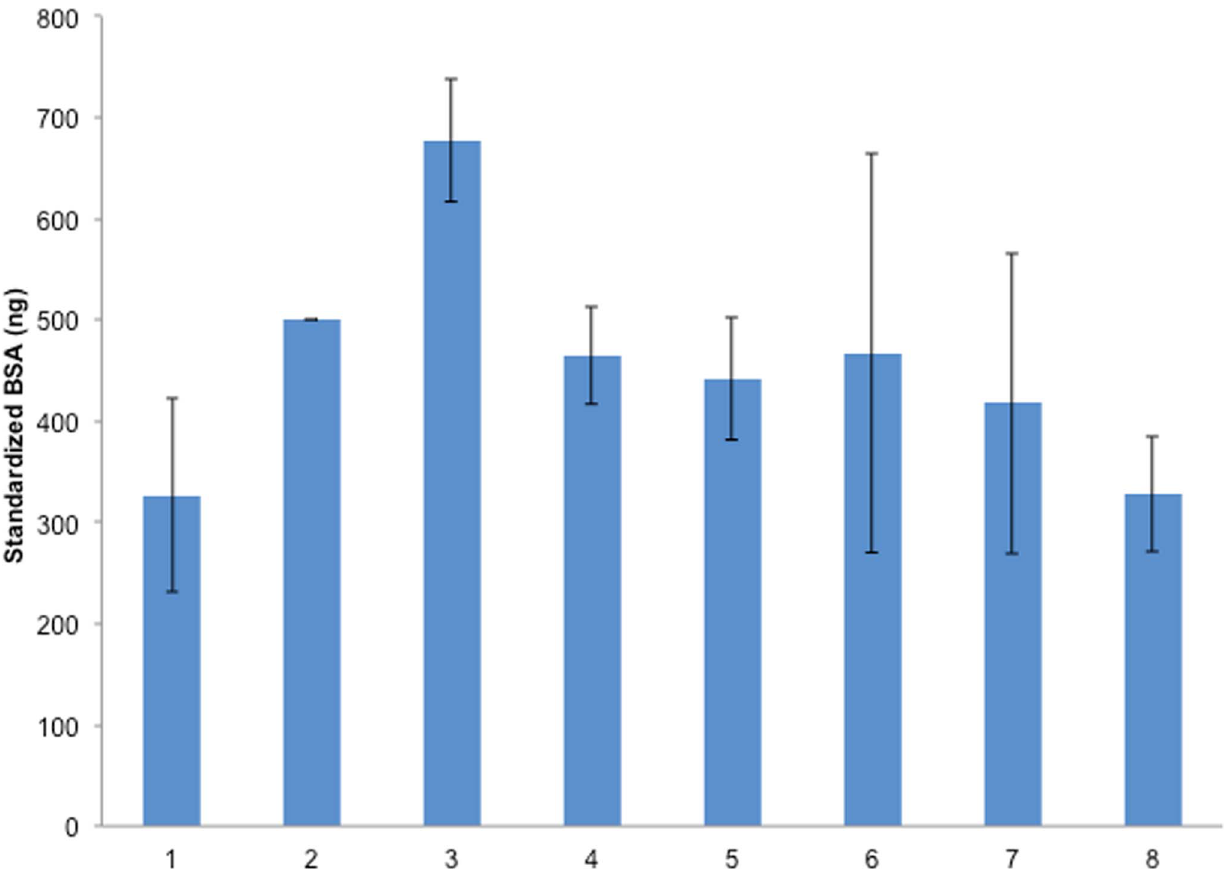
Figure 3. The band intensities of standardized BSA, and polymer solutions. Column 1:250 ng standardized BSA stock solution. Column 2:500 ng standardized BSA stock solution. Column 3:750 ng standardized BSA stock solution. Column 4: BSA-loaded HPC MNs (500 ng of each was used). Column 5: BSA-loaded Chitosan MNs (500 ng of each was used). Column 6: BSA-loaded PVA-gelatin MNs (500 ng of each was used). Column 7: Recovered BSA from loaded sodium alginate (SA) MNs (Day 7). Column 8: Recovered BSA from loaded sodium alginate (SA) MNs (Day